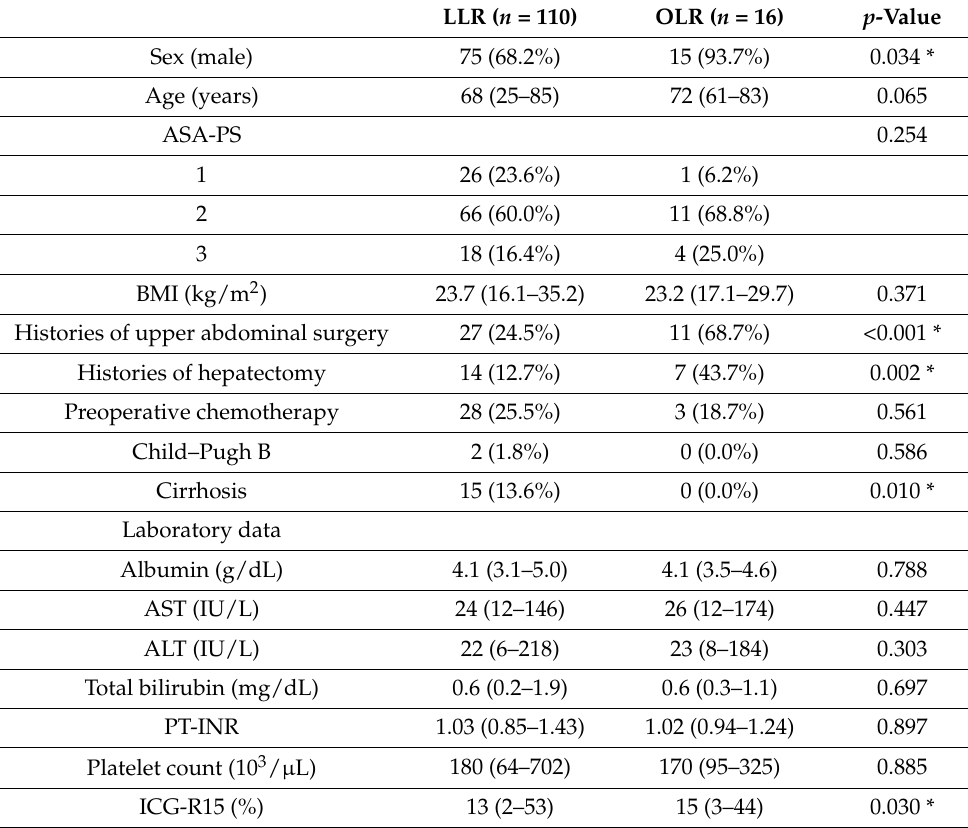
Table 1. Characteristics of all patients that underwent PSH for lesions in PSS 7 and